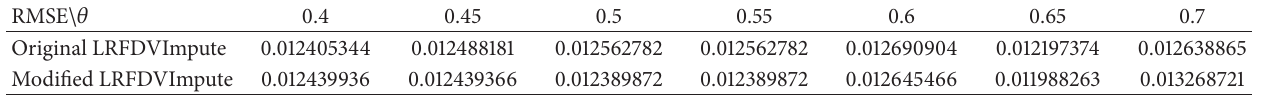
Table 2: Results for missing value estimation algorithm (Spellman, alpha).